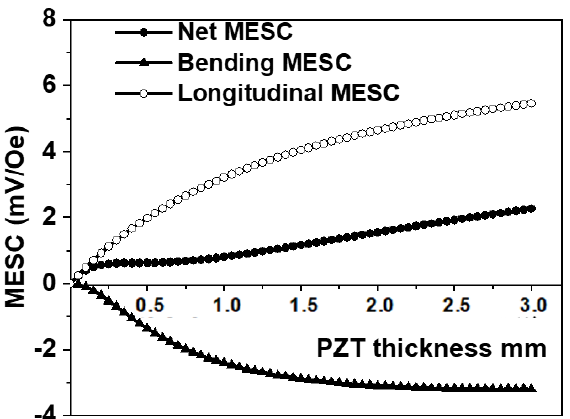
Figure 5. Estimated MESC vs. t p for a bilayer of Pe-PZT. The magnetostrictive layer thickness t m = 0.5 mm.